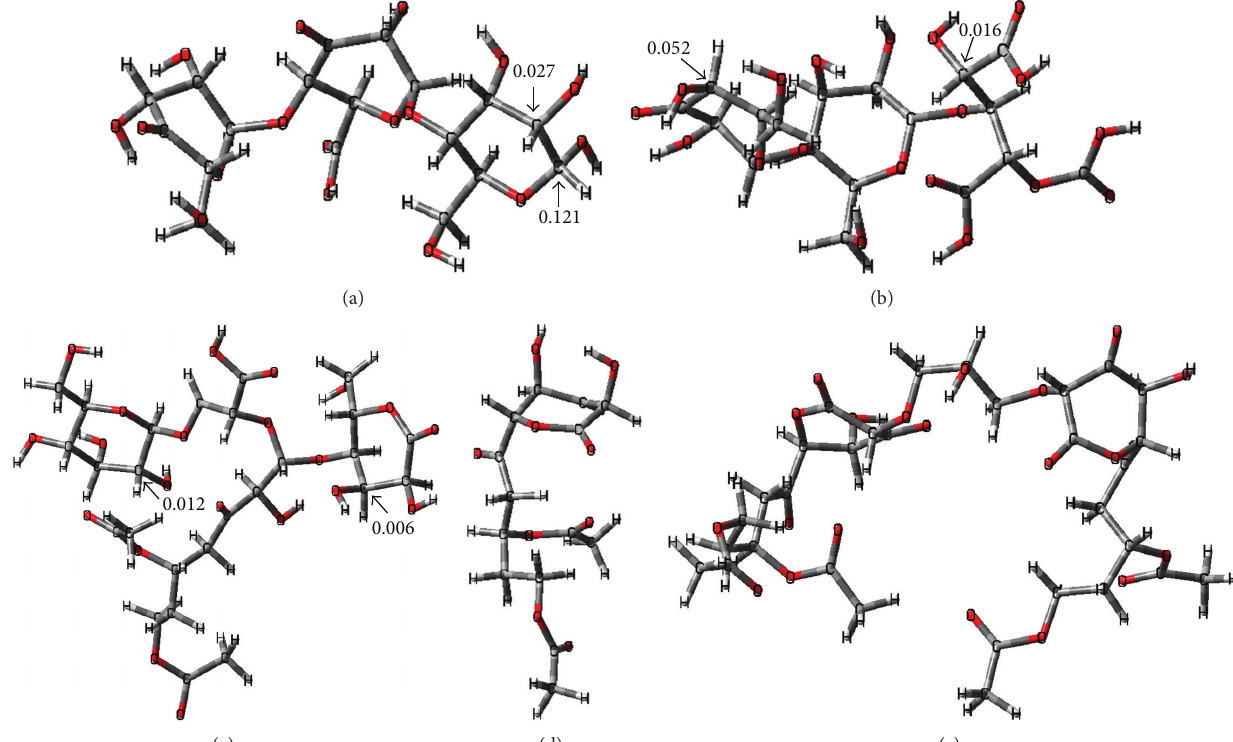
Figure 1: B3LYP/6-31G computational models of the oxidized modified starch molecules. (a) and (b) are the oxidized starch molecules, respectively; (c) and (d) are the oxidized grafted starch molecules, respectively; and (e) is the oxidized grafted cross-linked starch molecule. Additionally, some main Mulliken charges population in the molecules (a), (b), and (c) were indicated by